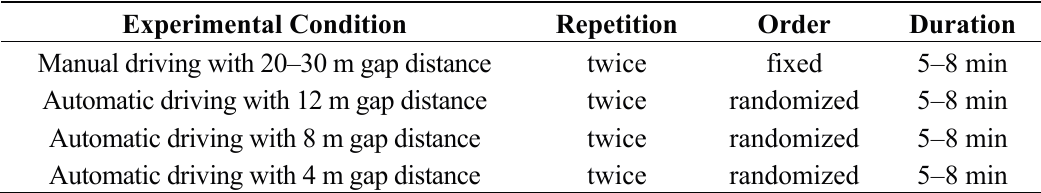
Table 1. Experimental condition, repetition, order, and